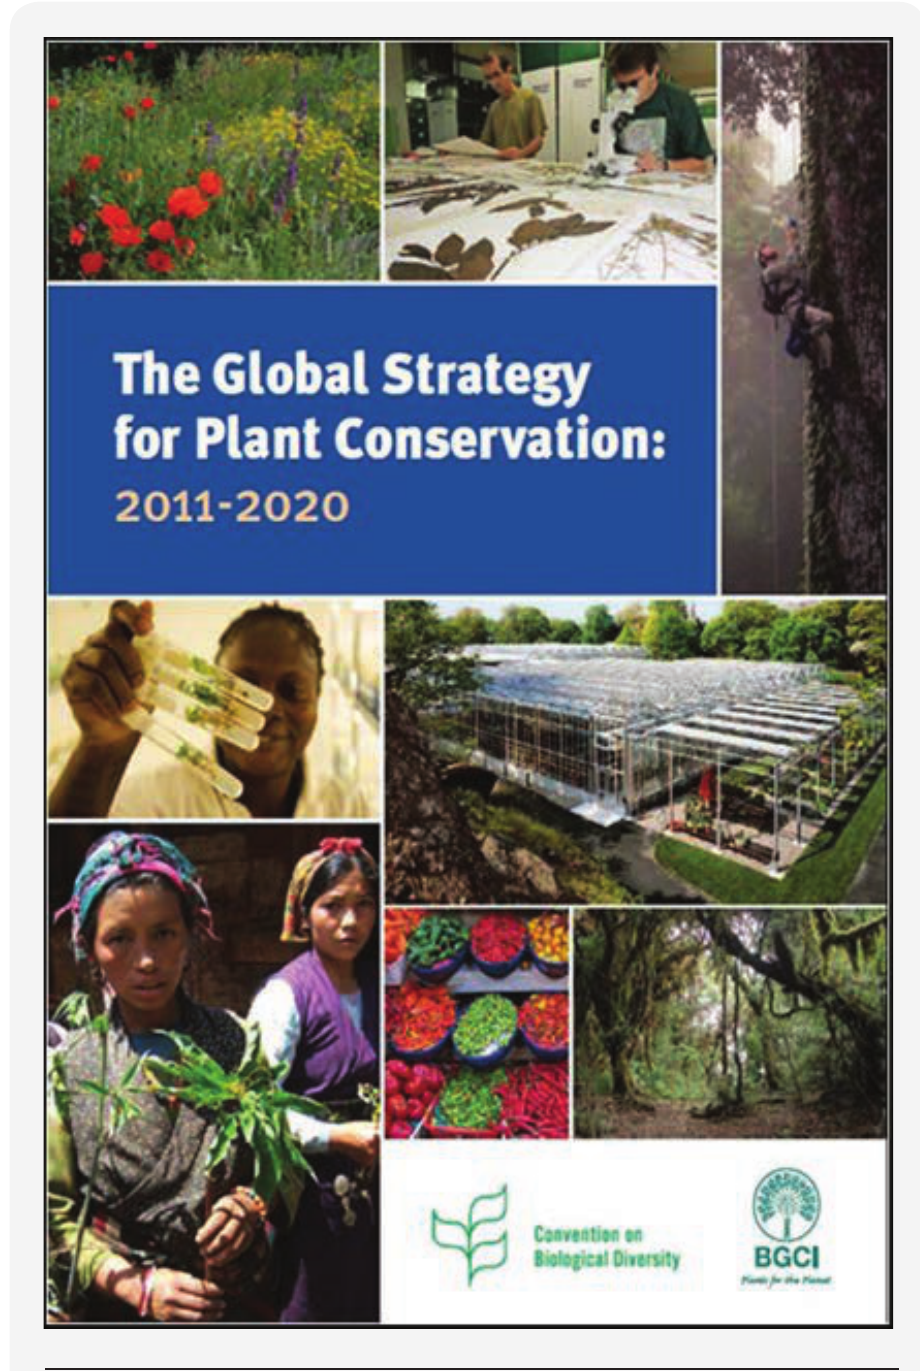
Figure 1. The Global Strategy for Plant Conservation, 2011–2020, provides an agreed international framework for plant conservation